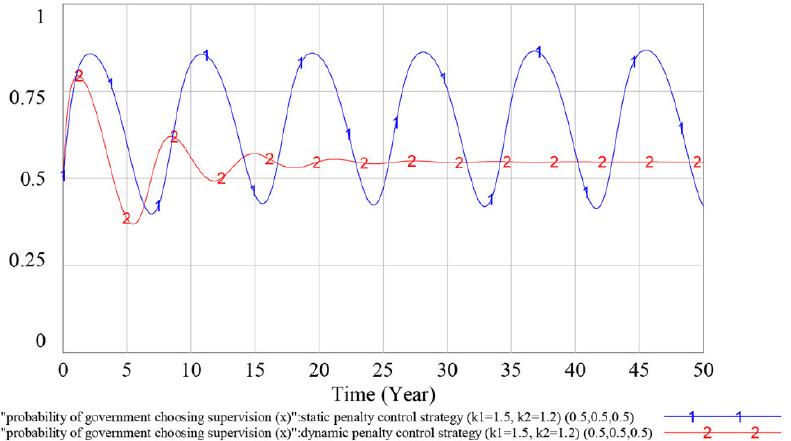
Figure 10. Influence of different penalty control strategies on the government’s strategy choices.